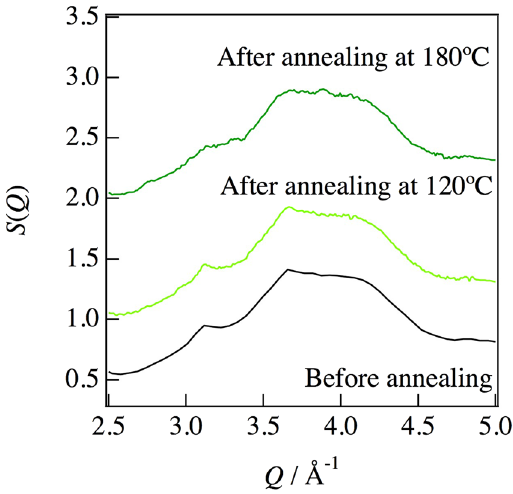
Figure 7. Structure factors in the range of 2.5–5.0 Å − 1 from Fig. 2 enlarged for clarity.